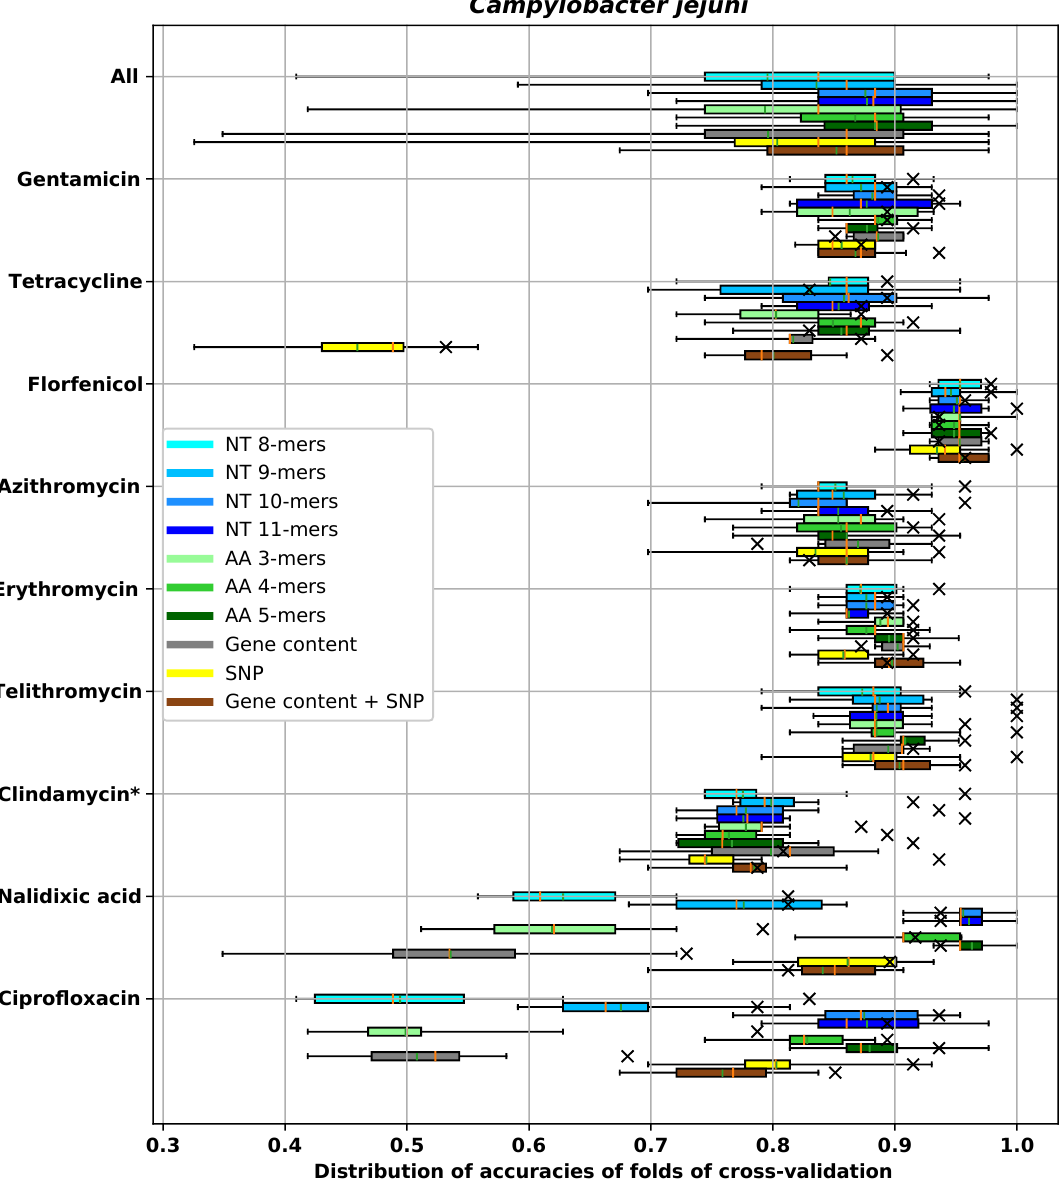
Figure 5. Distribution of ± 1 two-fold dilution accuracies in different methods for Campylobacter jejuni . The box plots are similar to Figure 4. The orange line represents the median and the green line represents the mean. The × marks represent the accuracy of the hold-out set. The antibiotic used for hyper-parameter tuning is indicated by an asterisk. For each method, the top boxes, labeled as “All,” were obtained by combining all ten folds for all